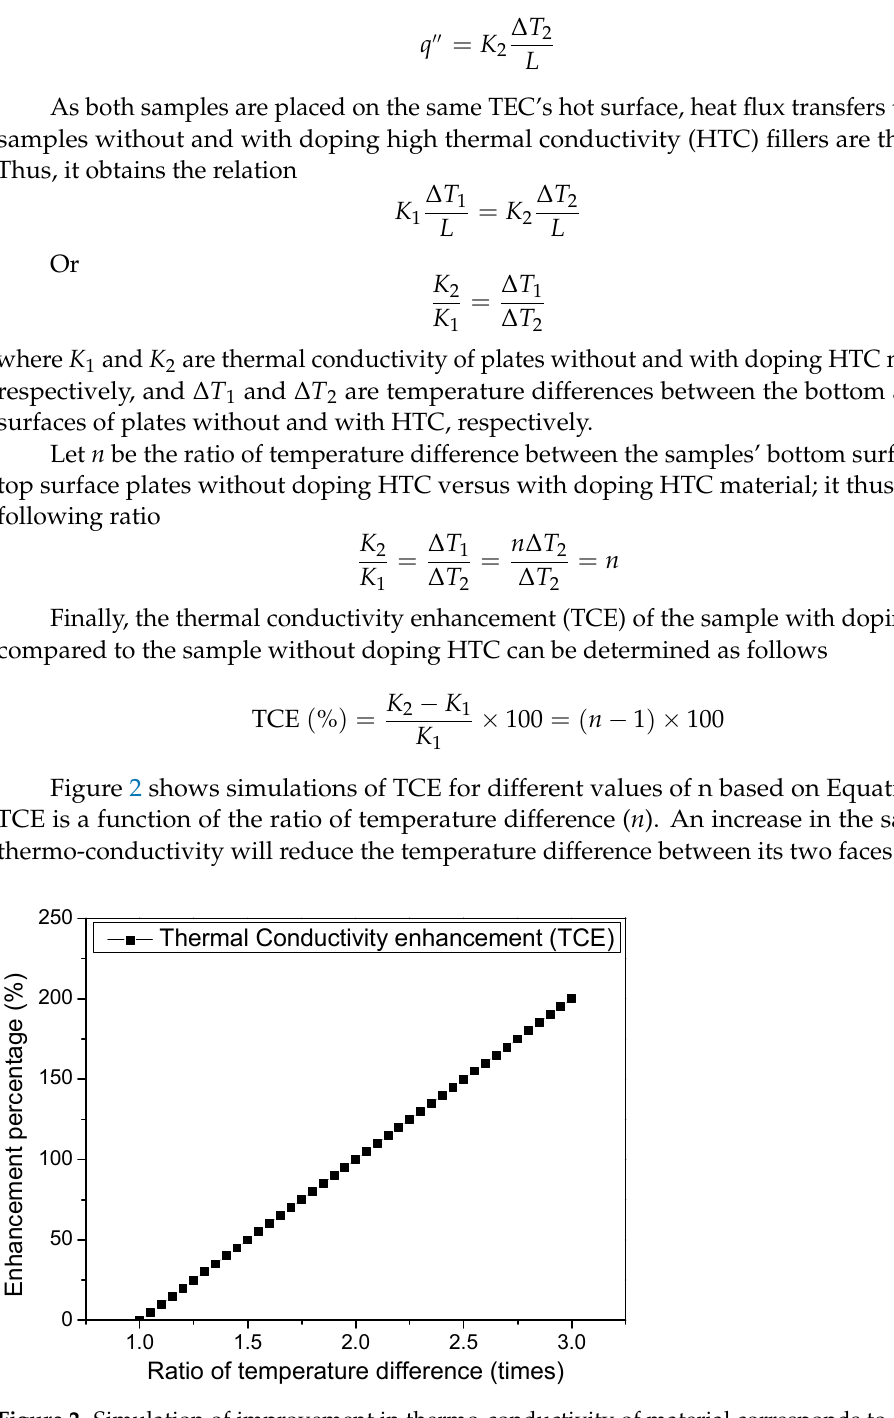
Figure 2. Simulation of improvement in thermo-conductivity of material corresponds to different values of n based on Equation